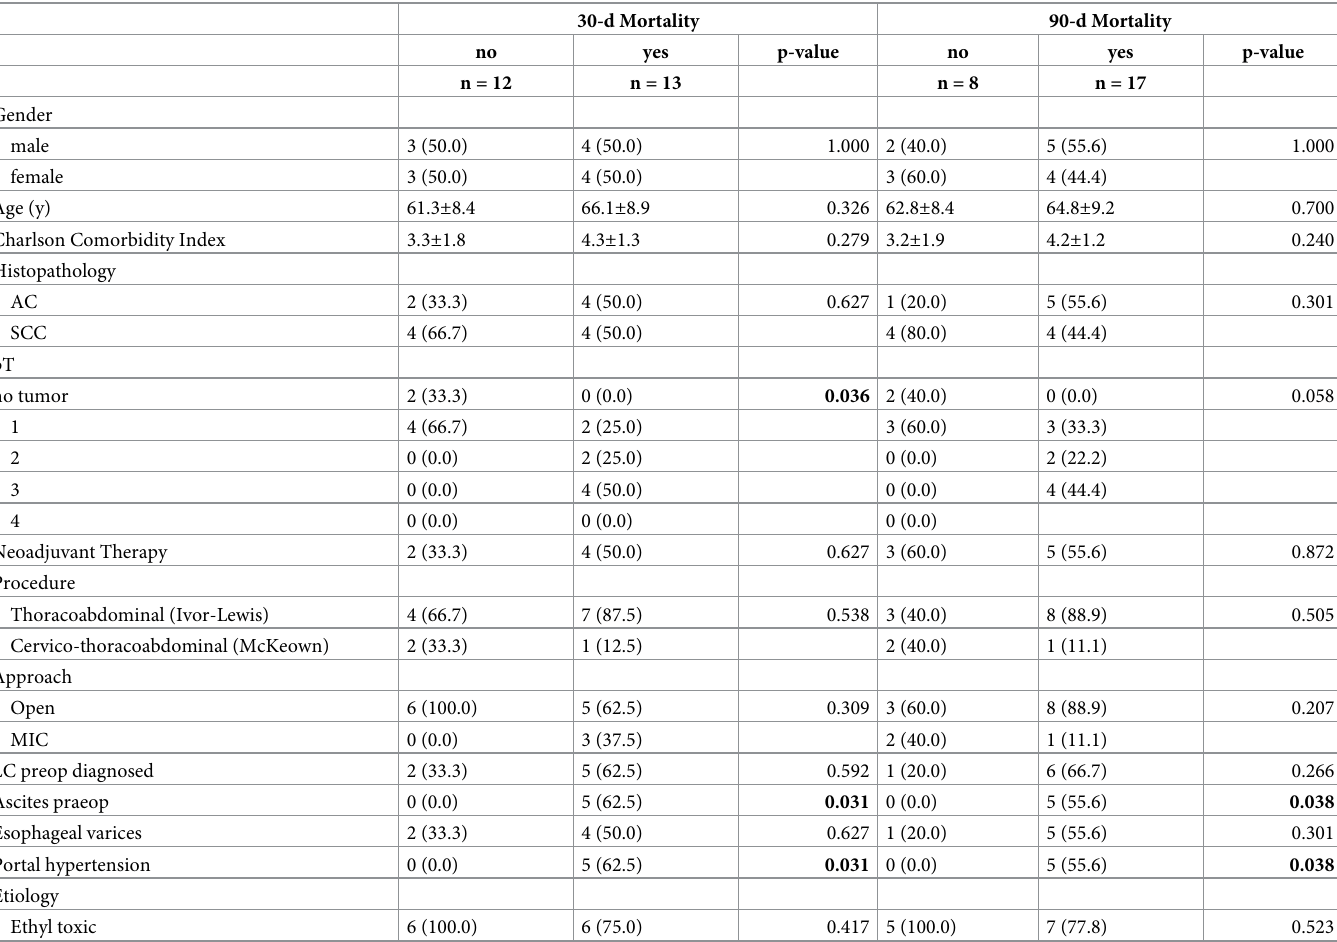
Table 5. Univariate analysis of 30-day and 90-day Mortality Rates of cirrhotic